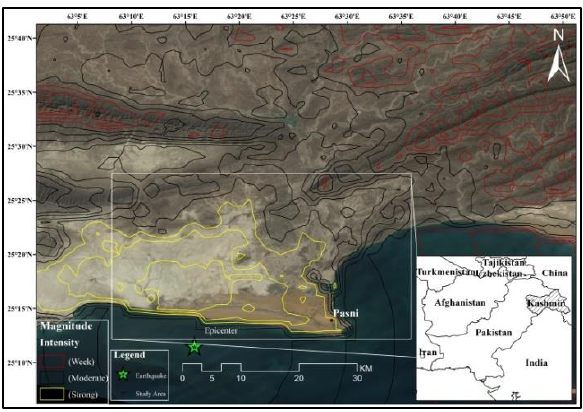
Figure 1. Natural color image showing the study area located in Makran coast and rectangular box identifying the area under processing. Contour lines with different colors showing the intensity of